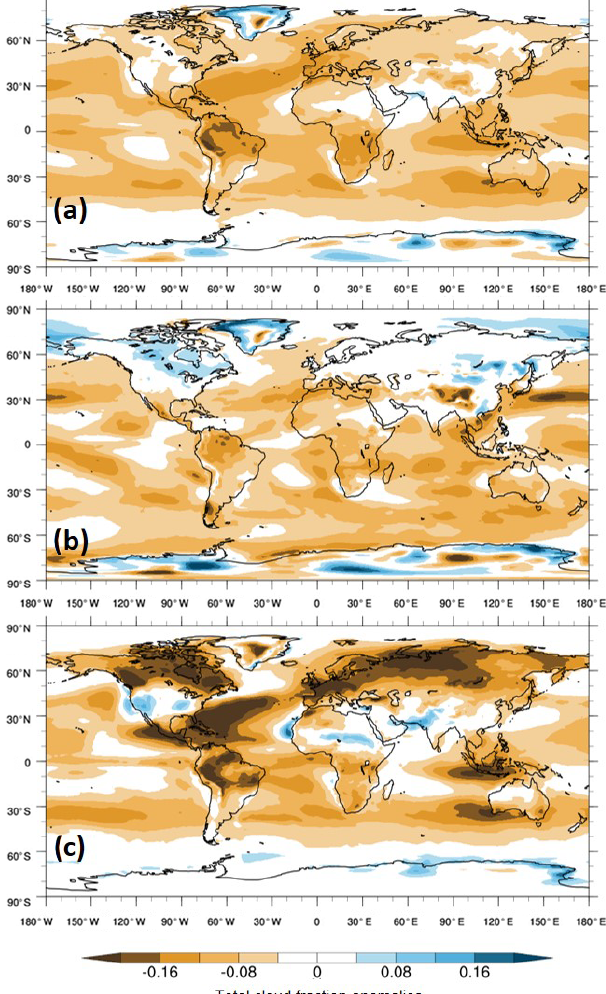
Figure 10. Total cloud fraction climatology differences ( mPWP − piControl_mod ) from HadGEM3: (a) annual, (b) DJF and (c)